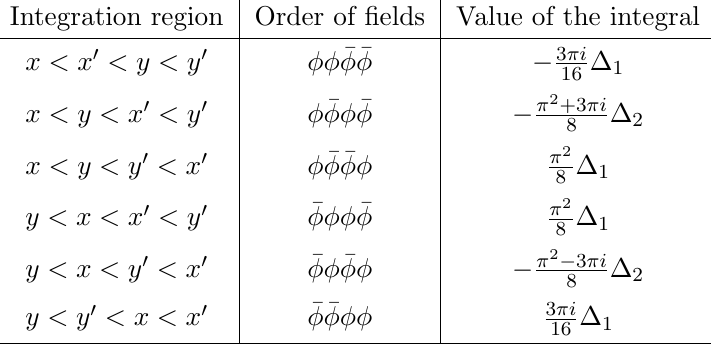
Table 2 . The coe(cid:14)cient in the four-point function (4.3). Integration region Order of (cid:12)elds Value of the integral